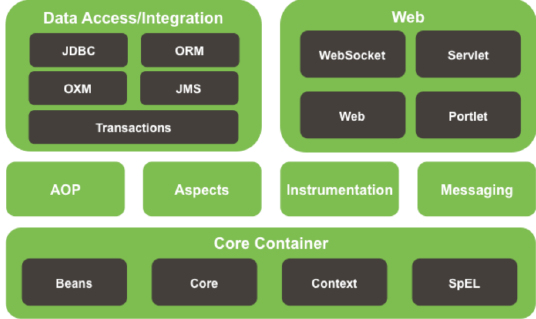
Figure 7. The stack of the Spring framework.